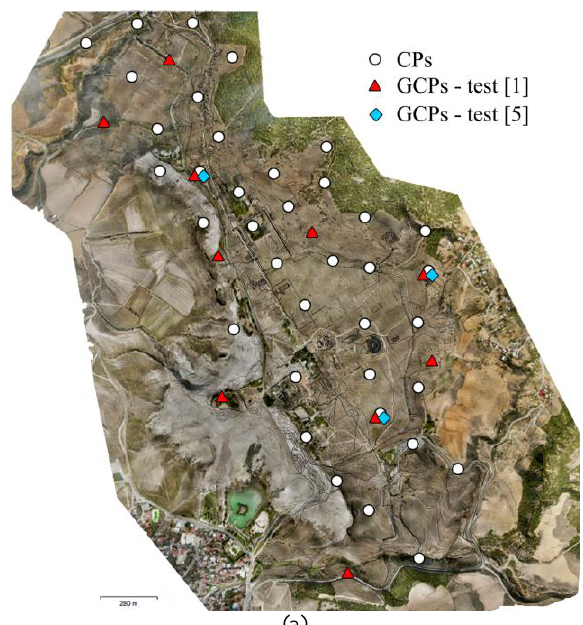
Figure 6. (a) The GCPs and CPs distribution in the test [1]- standard BBA and in the test [2]-PPK camera